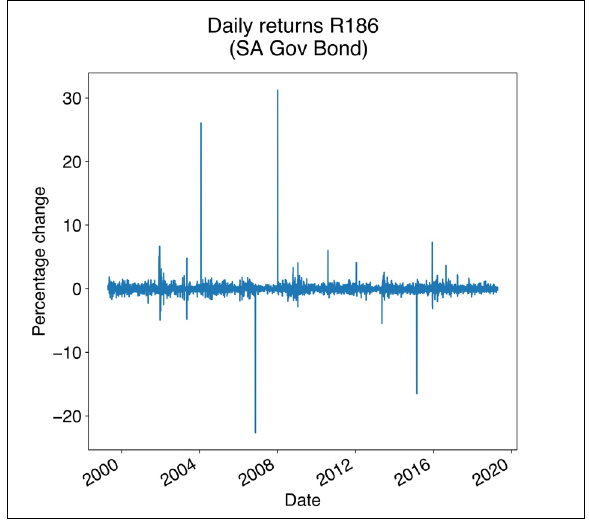
Daily price returns of the ZAR186 10-year South African government bond; y -axis displays price change in proportion, i.e. a maximum of 30%.